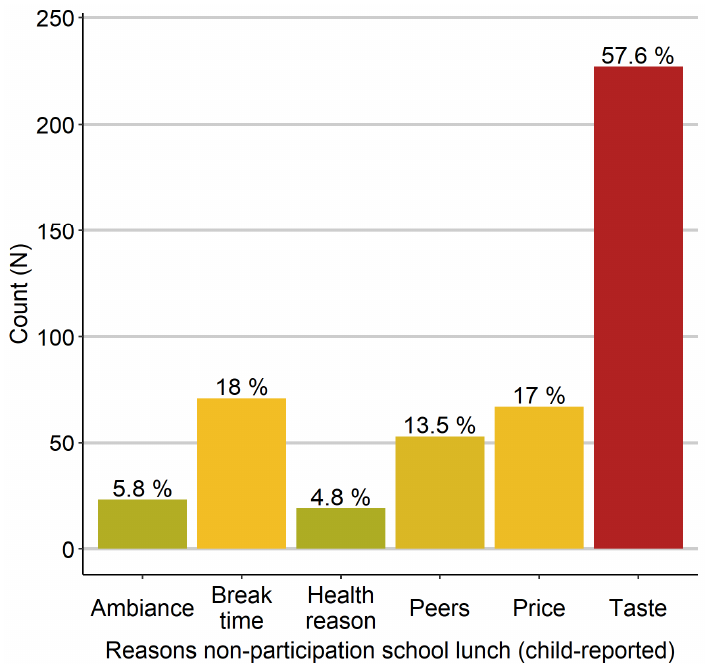
Figure 3. Absolute and relative frequencies of reasons for nonparticipation in school lunch (child- reported). More frequently reported reasons are shown in red, less frequently reported reasons are shown in green/yellow.